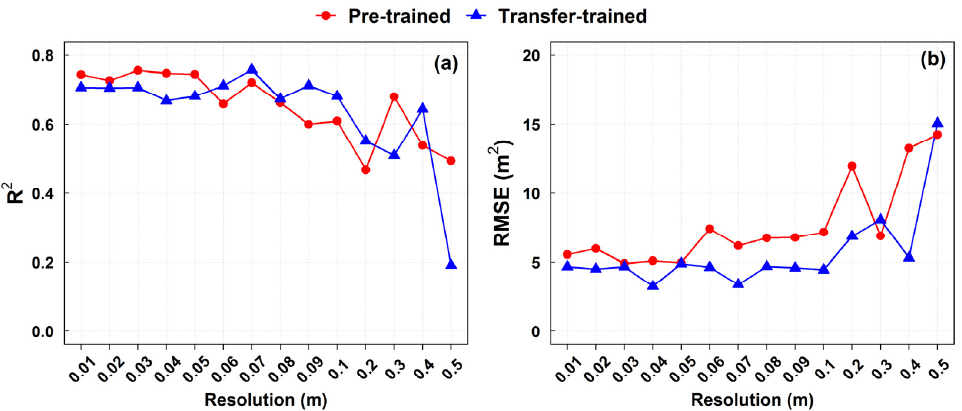
Figure 8. The R 2 (coefficient of determination) ( a ) and RMSE (root-mean-square error) ( b ) of the tree crown area estimation using the pre-trained and transfer-trained Detectree2 methods.